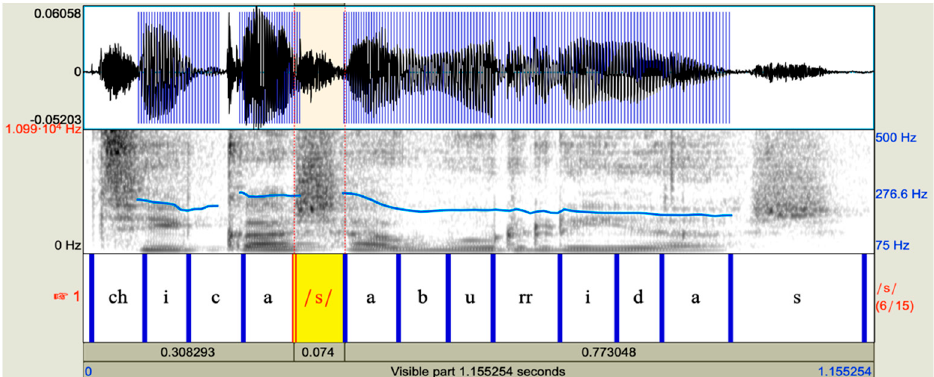
Figure 2. Younger L1-Spanish male rendition of caminarà/S/ aquí (‘you will walk here’) in Barcelonan Catalan (~100% voiced).